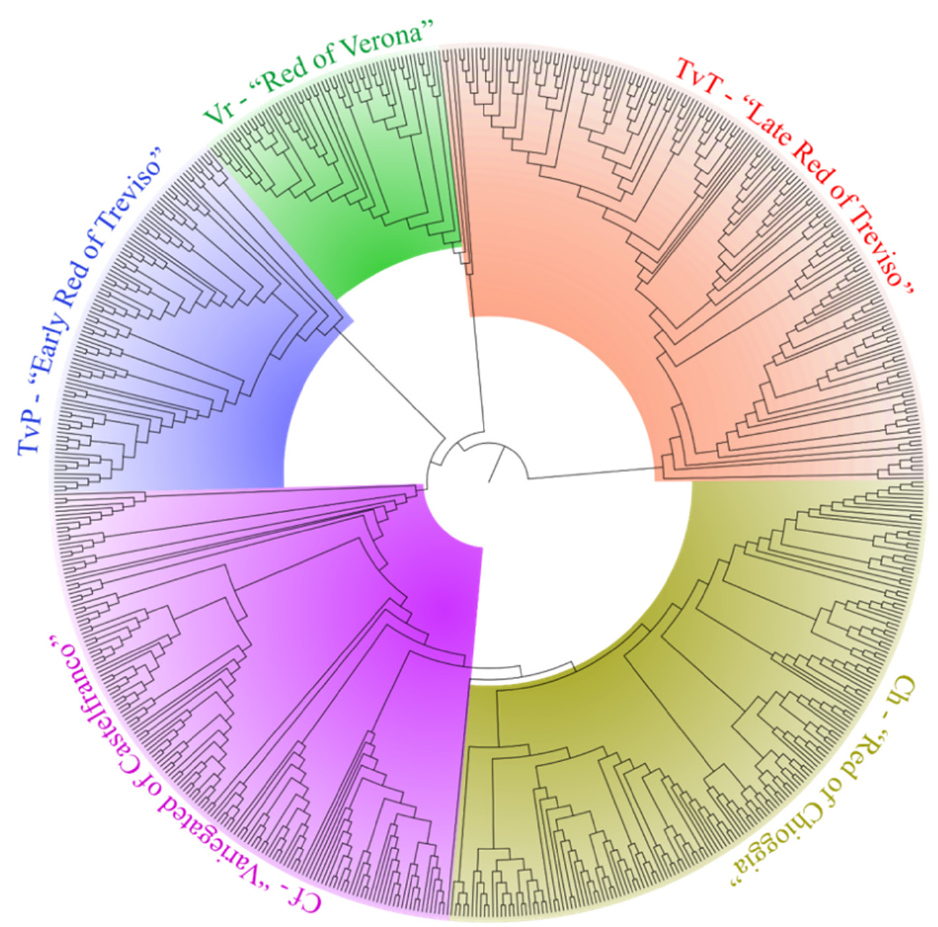
Figure 1. Maximum likelihood dendrogram topology ( − ln = 5698.207) depicting the genetic relation- ships among the different